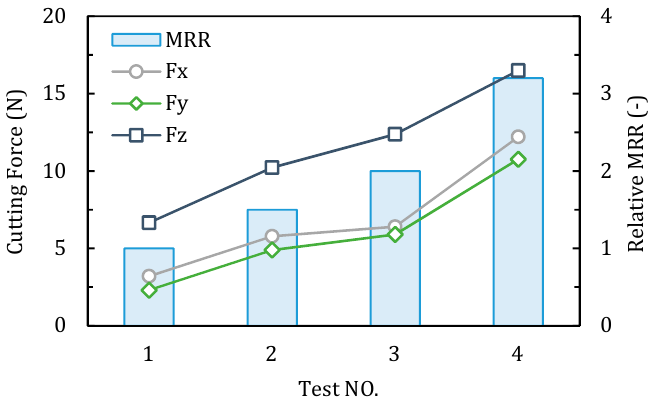
Figure 9. Cutting force and relative material removal rate (MRR) of each test in case 2.